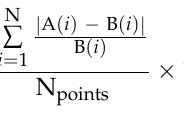
Table 4. An evaluation the slice area of a 1024-point FFT implementation with the various architectures. DSP48Es BRAMs MethodsResources # of Slices